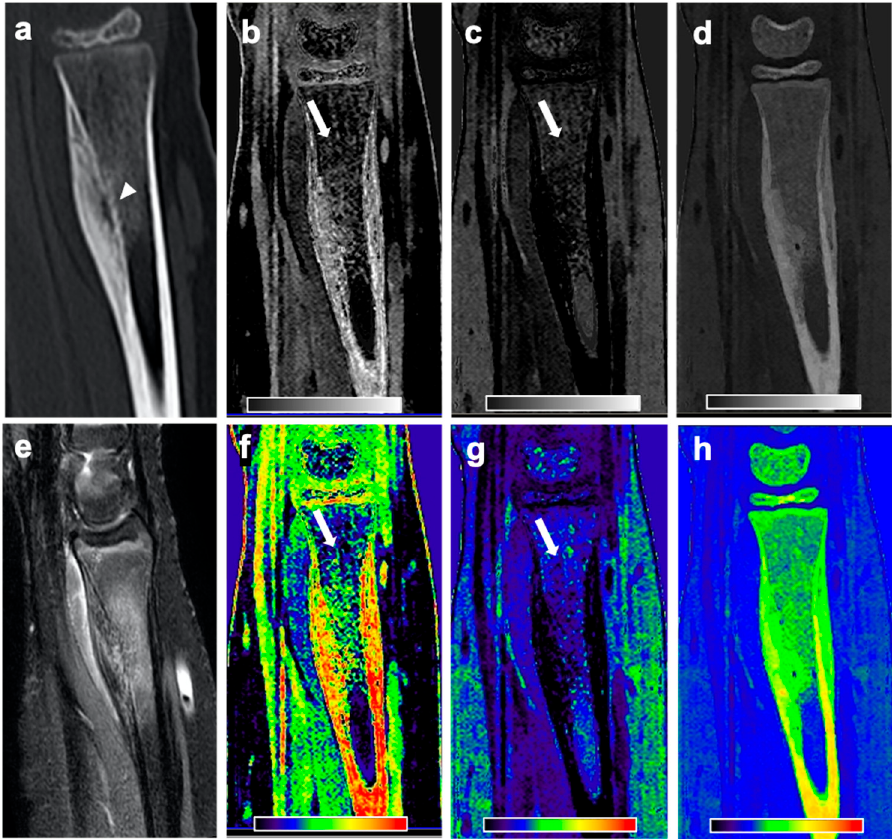
Figure 3. CT and MR images of a 12-year-old female patient with subperiosteal OO in the right distal radius. Sagittal CT reformation image ( a ) reveals the nidus in the right distal radius with surrounding sclerosis and a solid periosteal reaction (arrowhead). Material-specific volume fraction maps for red marrow/water ( b ), yellow marrow/fat ( c ), and hydroxyapatite ( d ), and respective color-coded overlays ( f – h ) reveal an increase in water-specific volume fraction in the red-marrow map ( b , f ; arrow) and a decrease in fat-specific volume fraction in the yellow-marrow map ( c , g ; arrow) in the right femoral neck, compared to the respective area on the other side. The corresponding sagittal STIR MR image confirms the presence of an edema-equivalent signal alteration in the bone marrow around the nidus ( e ).